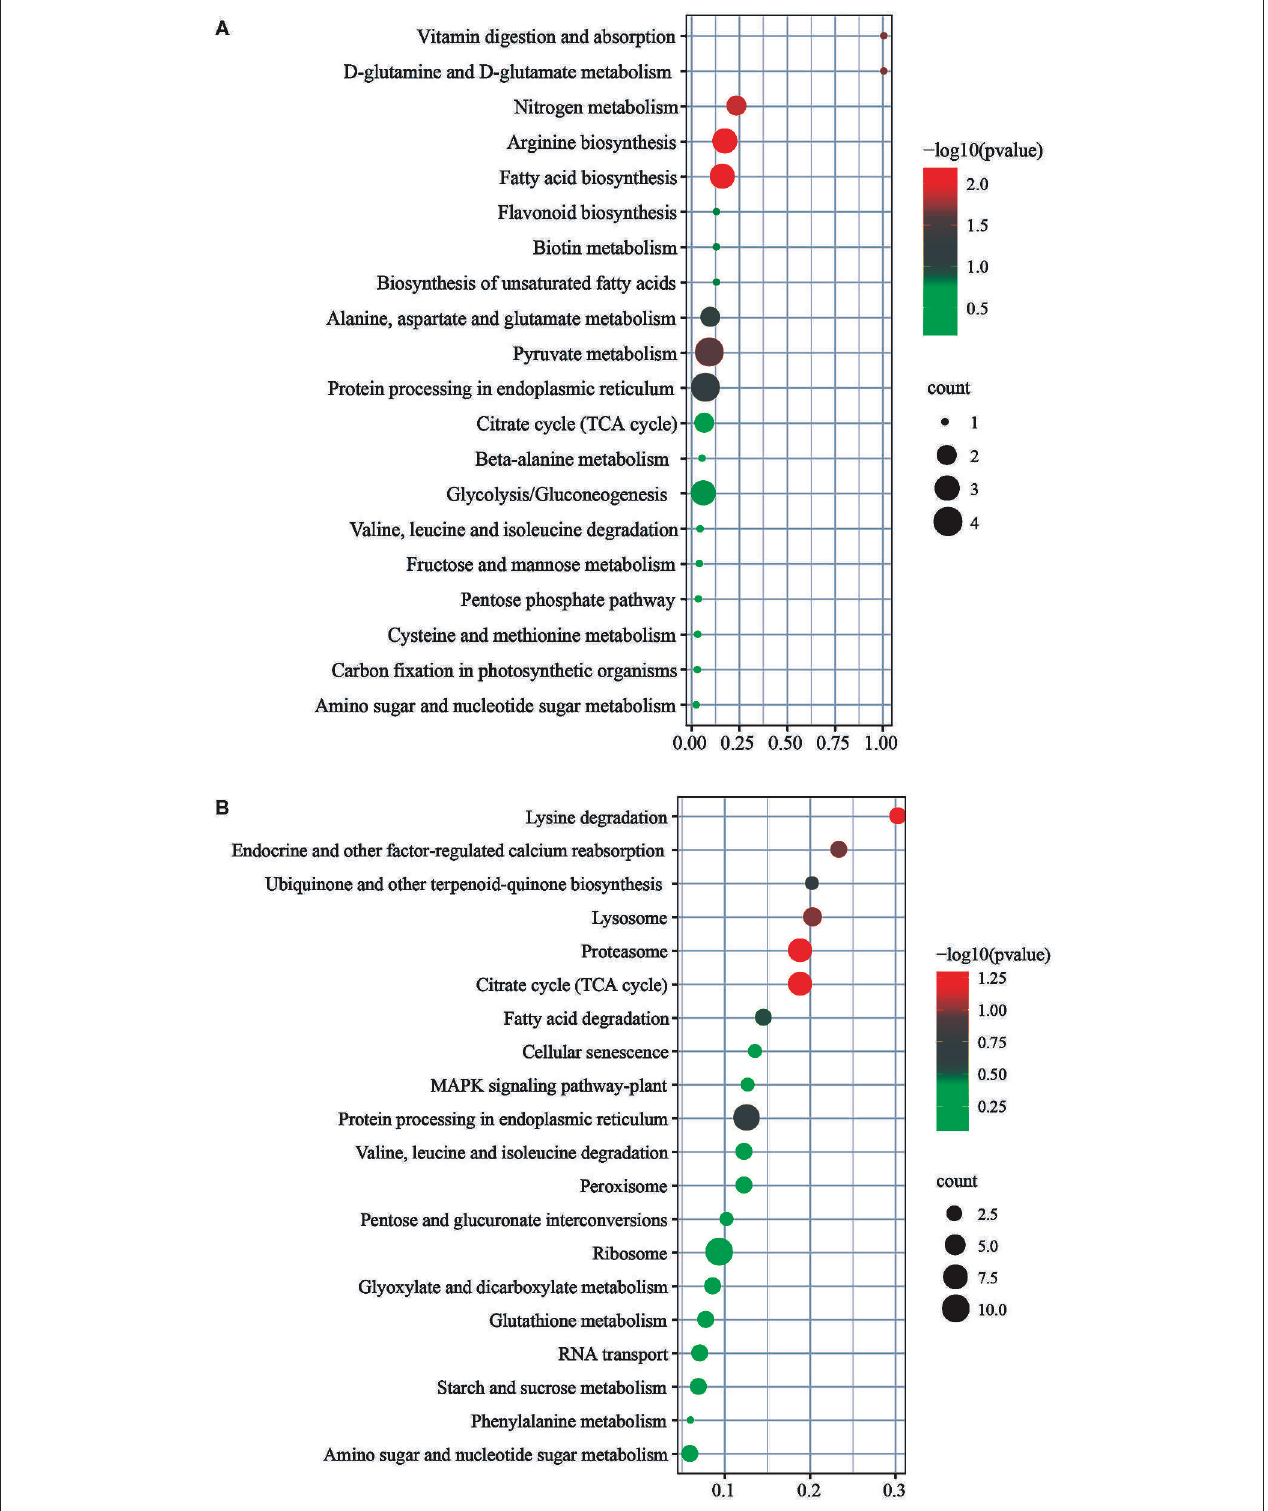
FIGURE 5 | KEGG pathways analysis of DAPs in HR_UR and FR_HR. (A) HR_UR; (B) FR_HR. The horizontal axis shows the rich factor, which represents the ratio of DAPs to total proteins identified in KEGG pathway functional category. The vertical axis shows the top enriched KEGG pathways. The color and size of each circle indicates p values and number of the proteins enriched in each term.